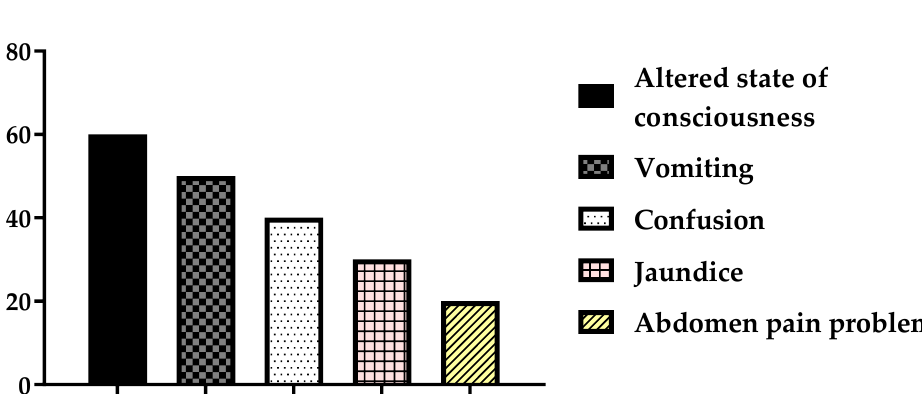
Figure 1. Distribution of the major complaints among the participants due to alcohol consumption. The patients underwent liver function tests (LFTs), and 72 (28.8%) exhibited abnormal liver function; see Figure 2. The remaining 178 (71.2%) patients were found to have normal liver function. It was found that 67 patients had abnormal renal function test (RFT) results, while the rest (183) had normal RFT results, as shown in Figure 3. The pancreatic functions of more than one third of the patients were found to be abnormal, i.e., 89 (35.6%), as shown in Figure 4. One death was reported due to alcohol abuse during the study period. This patient was unconscious upon arriving at the ER.